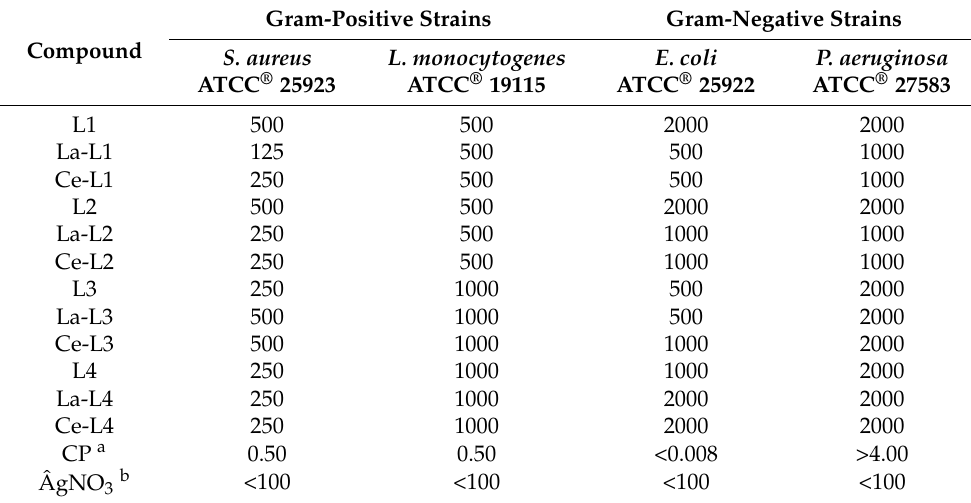
Table 2. In vitro antibacterial activities of Schiff bases and complexes